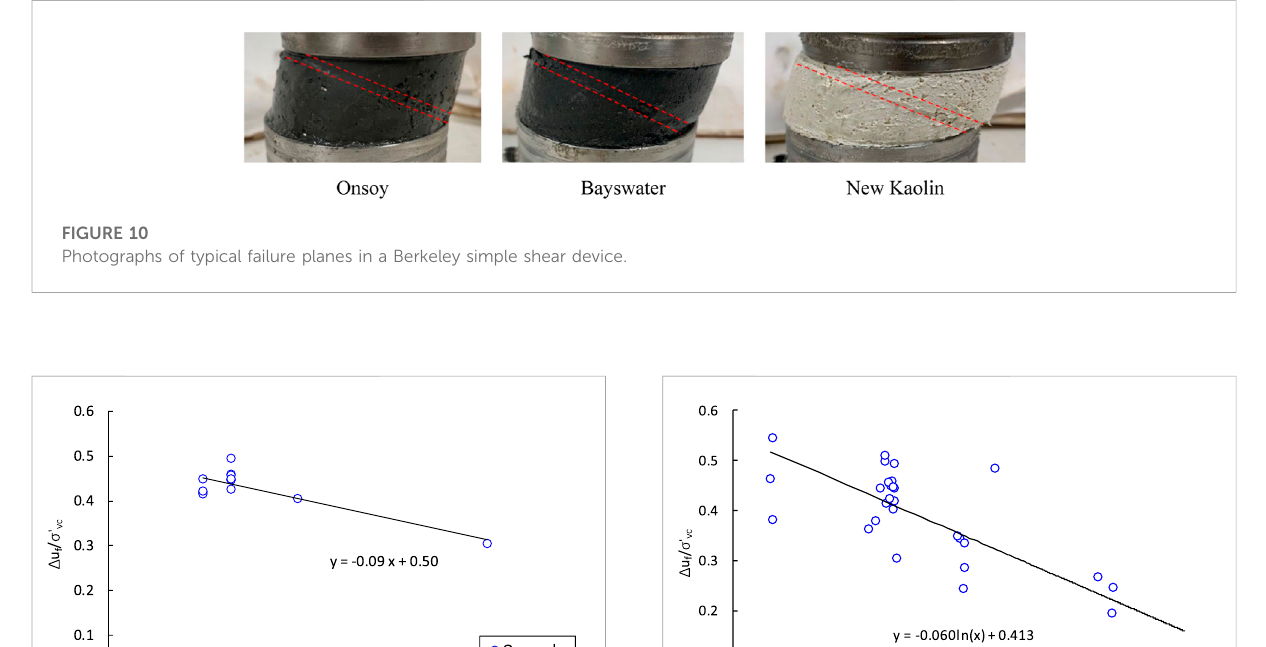
FIGURE 11 Variation in excess pore pressure to lateral stress ratio at failure.